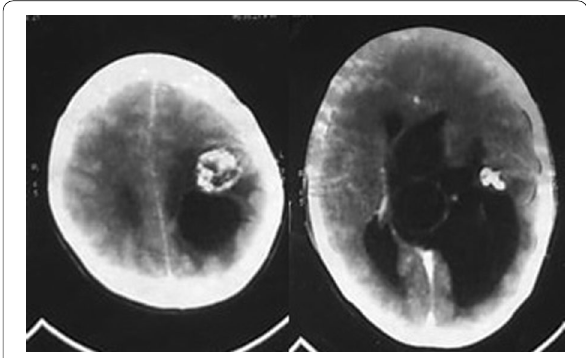
Fig. 3 Contrast-enhanced CT scan imaging showing heterogeneous cystic lesion with calcifications and multiple cystic lesions